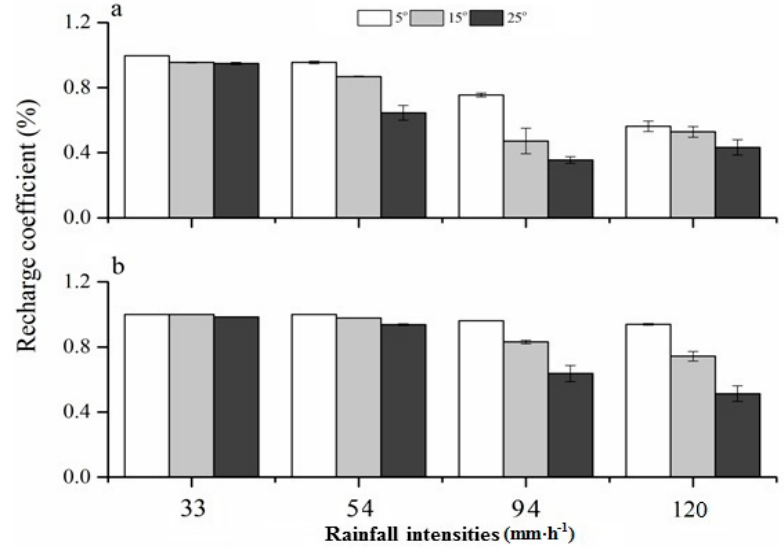
Figure 7. Effect of treatments on the recharge coefficient in ( a ) un ‐ mulched and ( b ) mulched